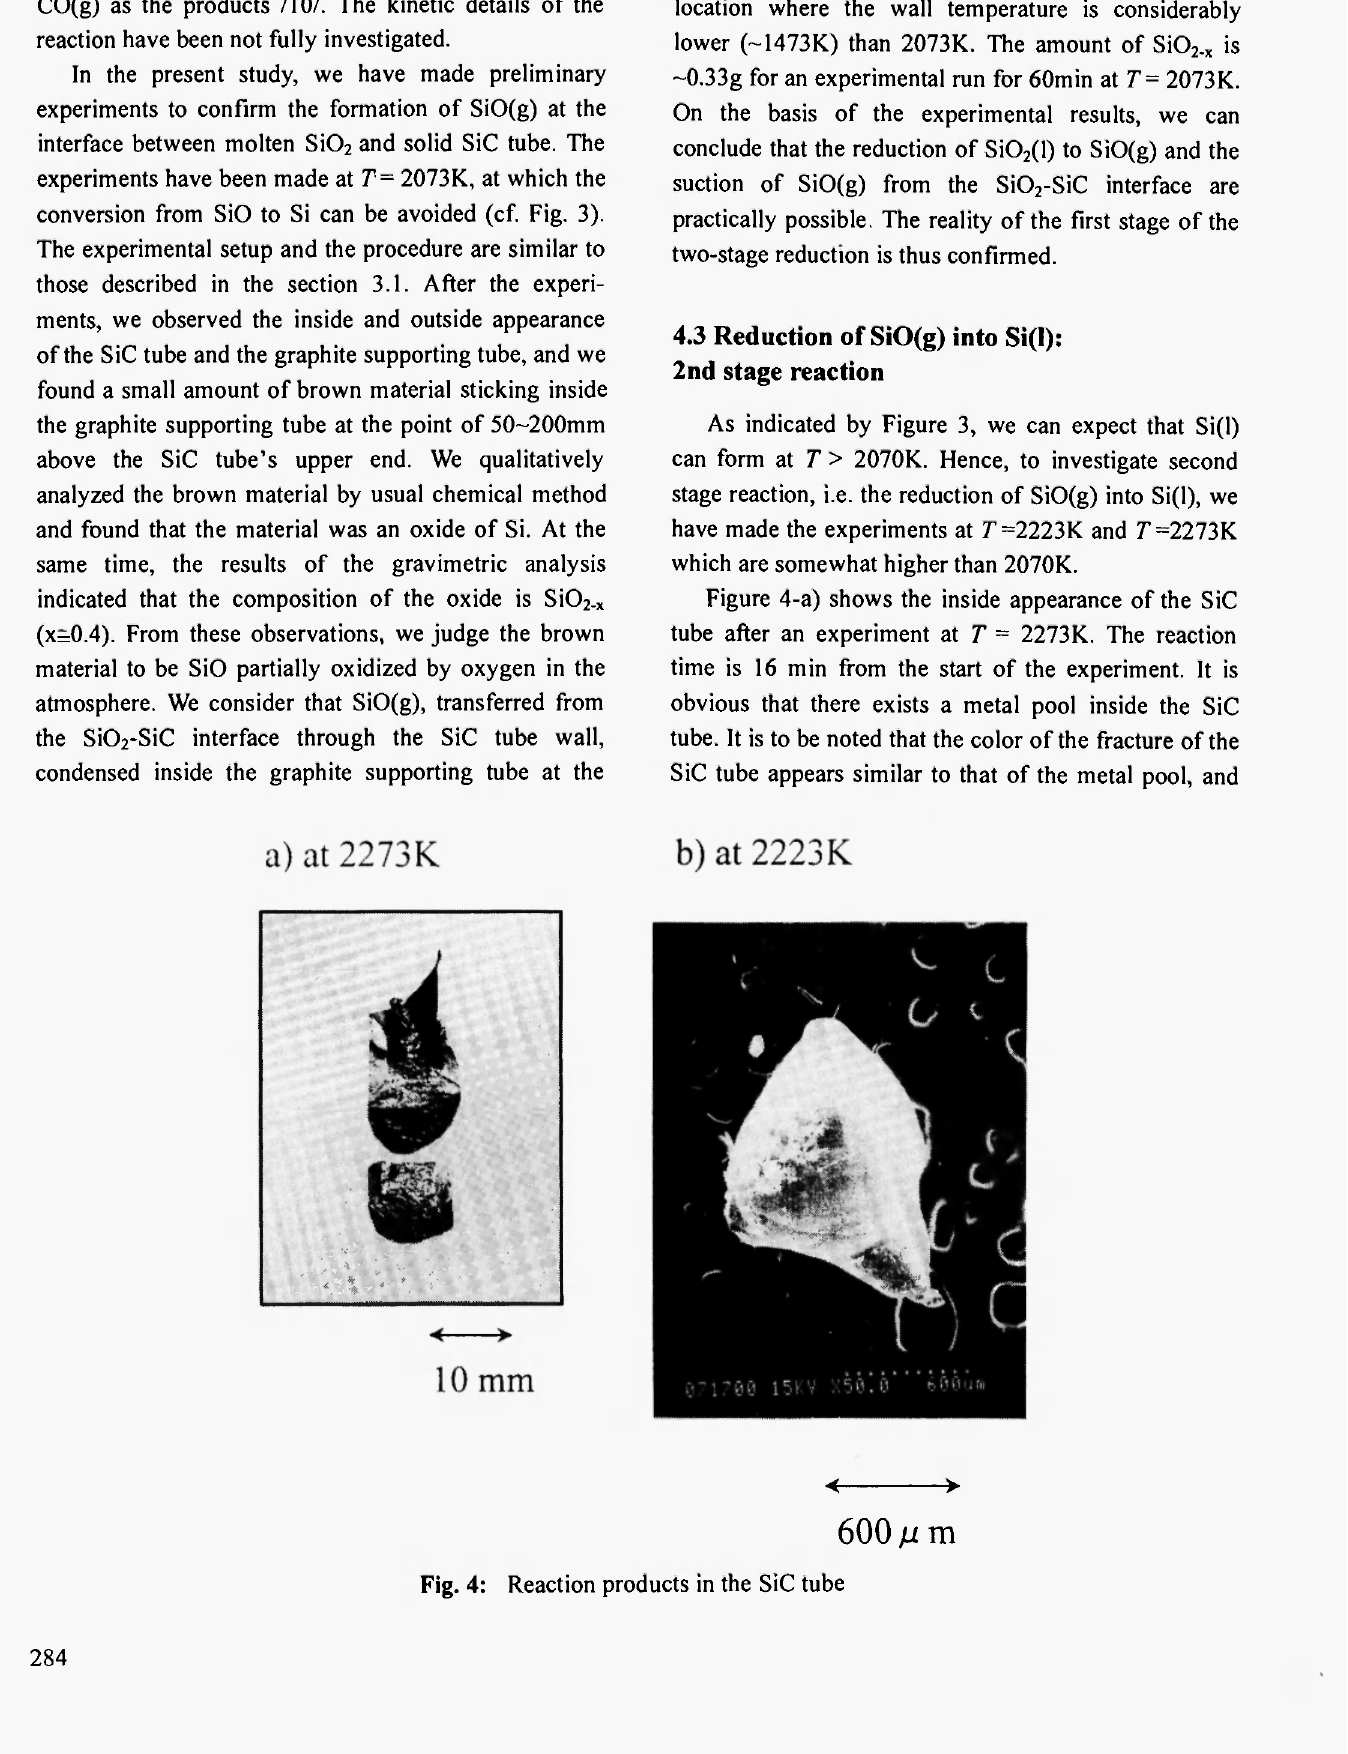
Fig. 4: Reaction products in the SiC